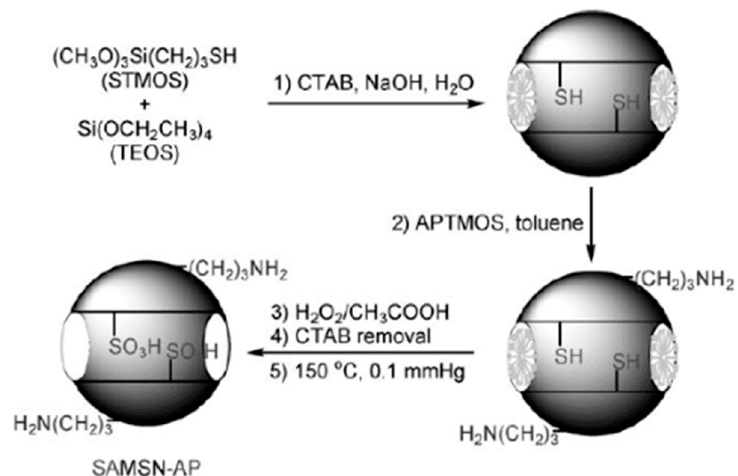
Figure 18. Syntheses of bifunctional mesoporous silica nanoparticles having sulfonic acid groups on the internal surface and organic amine groups on the external surface. Reproduced with permission from [26]. Copyright 2011 WILEY-VCH Verlag GmbH & Co. KGaA, Weinheim.